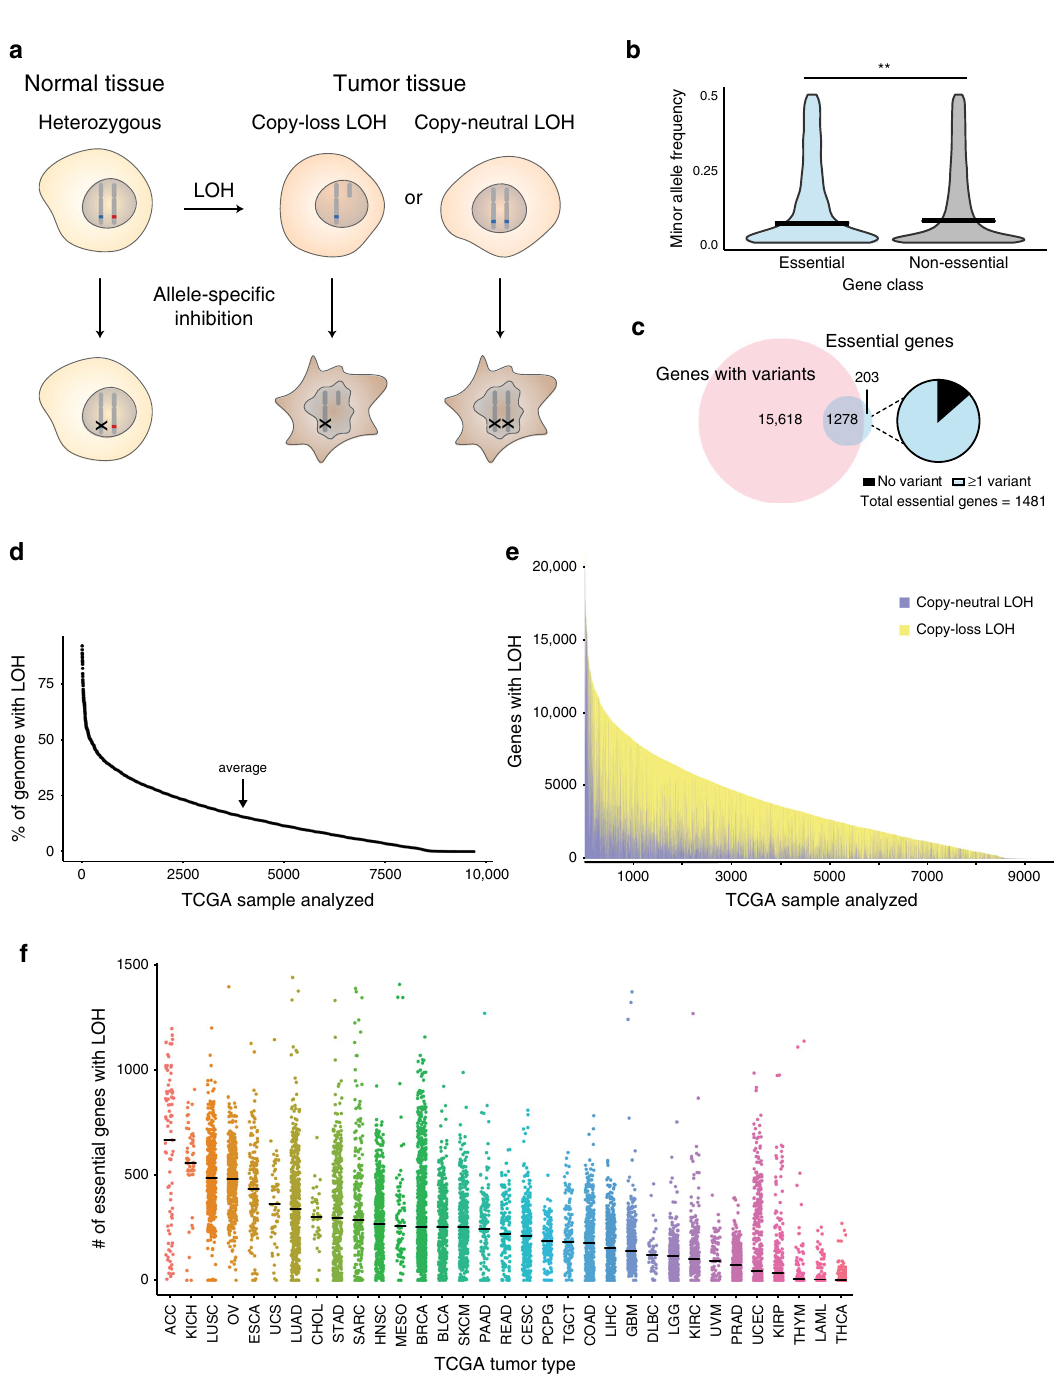
Fig. 1 Genomic rates of LOH and allelic variation in normal and cancer genomes. a Schematic indicating how loss of heterozygosity (LOH) of essential genes represents a potentially targetable difference between cancer and normal cells. b Violin plot of minor allele frequency of polymorphisms in essential versus non-essential genes in the ExAC cohort. Intersecting lines represent median values: essential = 0.141, non-essential = 0.146; one-tailed Student ’ s t -test, ** p = 0.005. c (Left) Overlap between genes with common polymorphisms in the ExAC database (pink circle) and essential genes (blue circle). (Right) Fraction of essential genes with common polymorphisms. d Percent of genome affected by LOH across 9686 cancers from TCGA. e Stacked histogram representing the number of genes with copy-loss (yellow) or copy-neutral LOH (purple) across 9686 cancers from TCGA. f Dot plot of the number of essential genes affected by LOH across 33 TCGA tumor types. Tumor types are indicated by TCGA abbreviations (see https://gdc.cancer.gov/ resources-tcga-users/tcga-code-tables/tcga-study-abbreviations). Each dot represents an individual sample. Lines indicate median